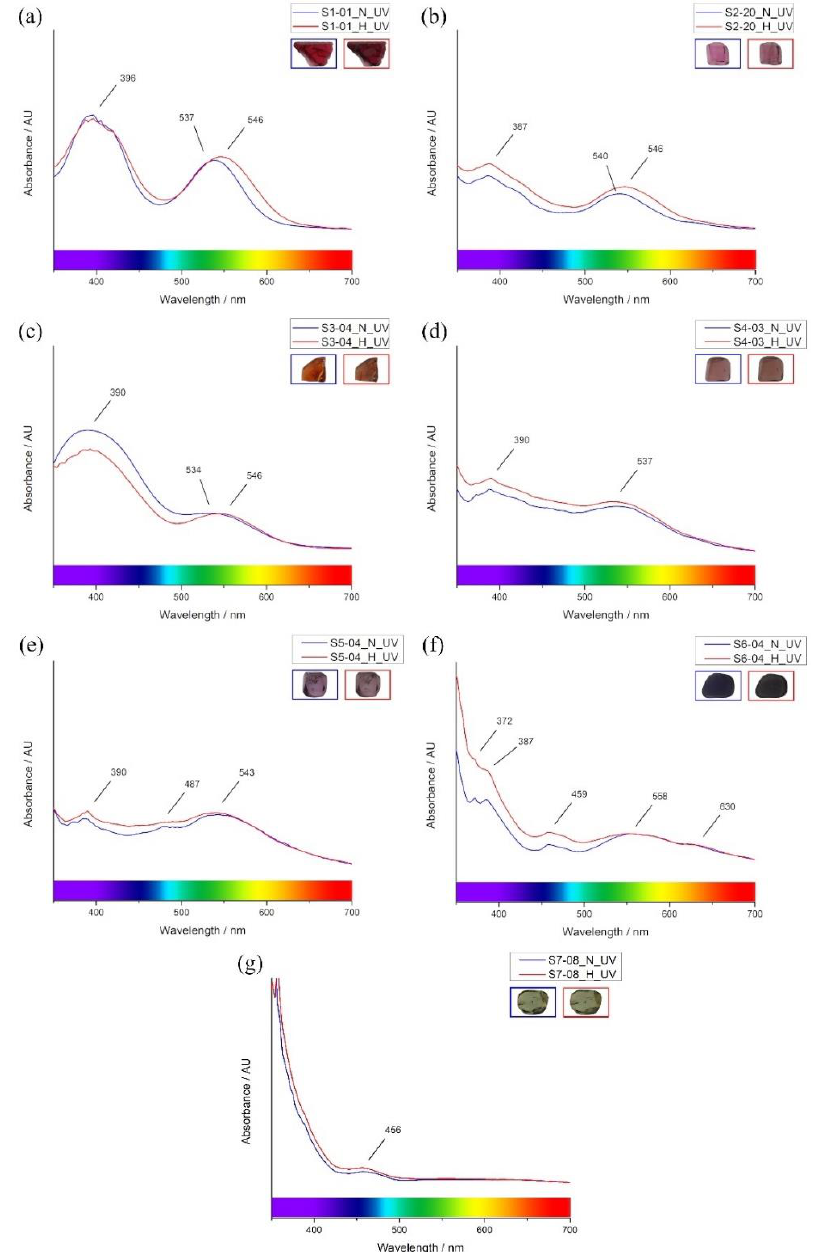
Figure 2. Representatives of UV-visible absorption spectra of ( a ) red spinel, ( b ) magenta spinel, ( c ) orange spinel, ( d ) red-purple spinel, ( e ) purple spinel, ( f ) blue spinel, and ( g ) green spinel and their pattern change after heating experiment under this study .